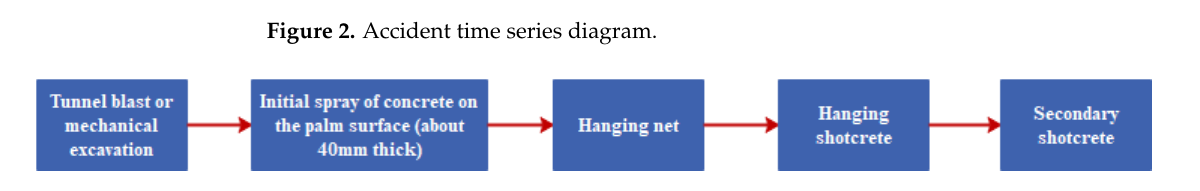
Figure 3. Construction process.